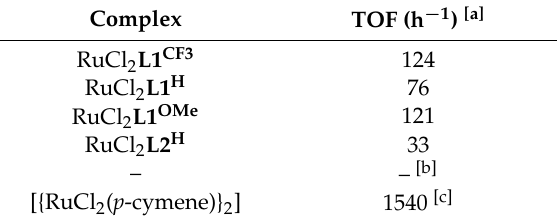
Table 4. Activities of RuCl 2 L catalysts in the formic acid decomposition